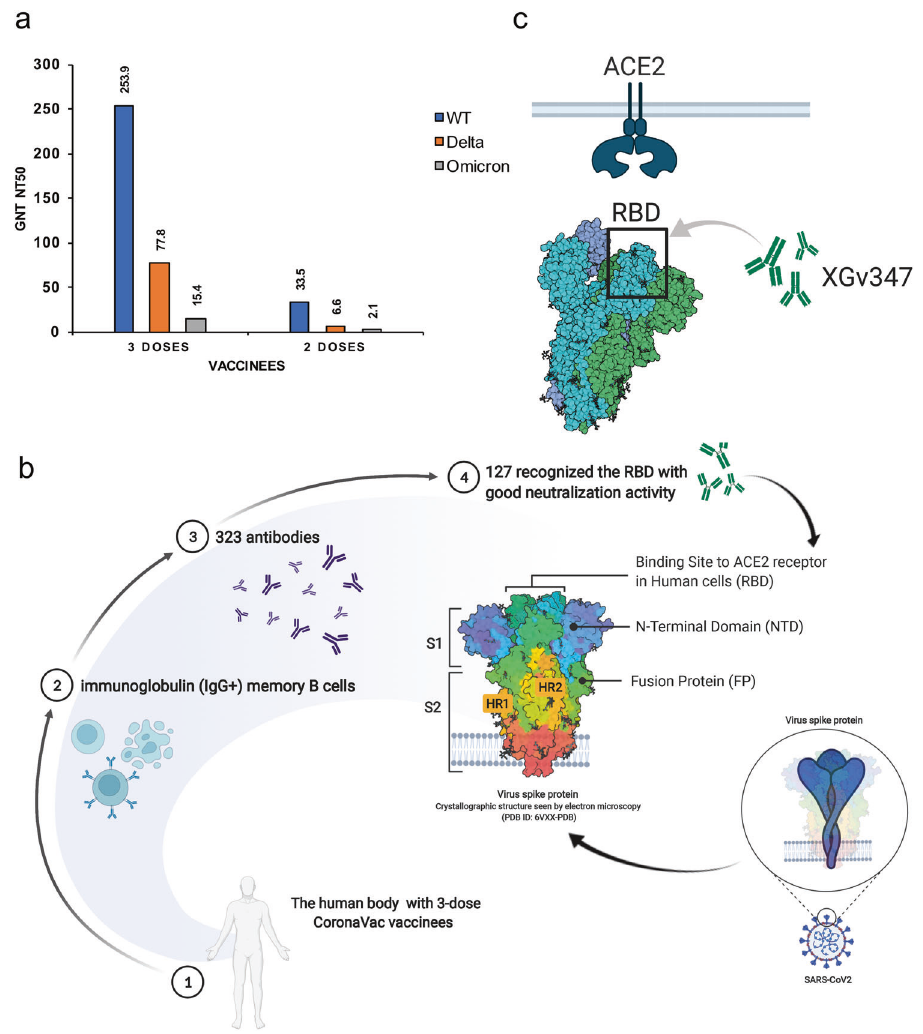
Fig. 1 a The GMT NT50 against VOCs from vaccinated volunteers with two and three doses. The neutralizations against the WT, Delta, and Omicron variants are shown as blue column, orange column, and gray column, respectively, the data are reproduced from the original article 1 with permissions. b The fl ow chart of the study. 1 c XGv347 activation mode. The model depicts a possible mechanism that XGv347 bound to an epitope at the tip of the RBD, largely overlapping with the patch targeted by ACE2. This fi gure was prepared using BioRender (https://